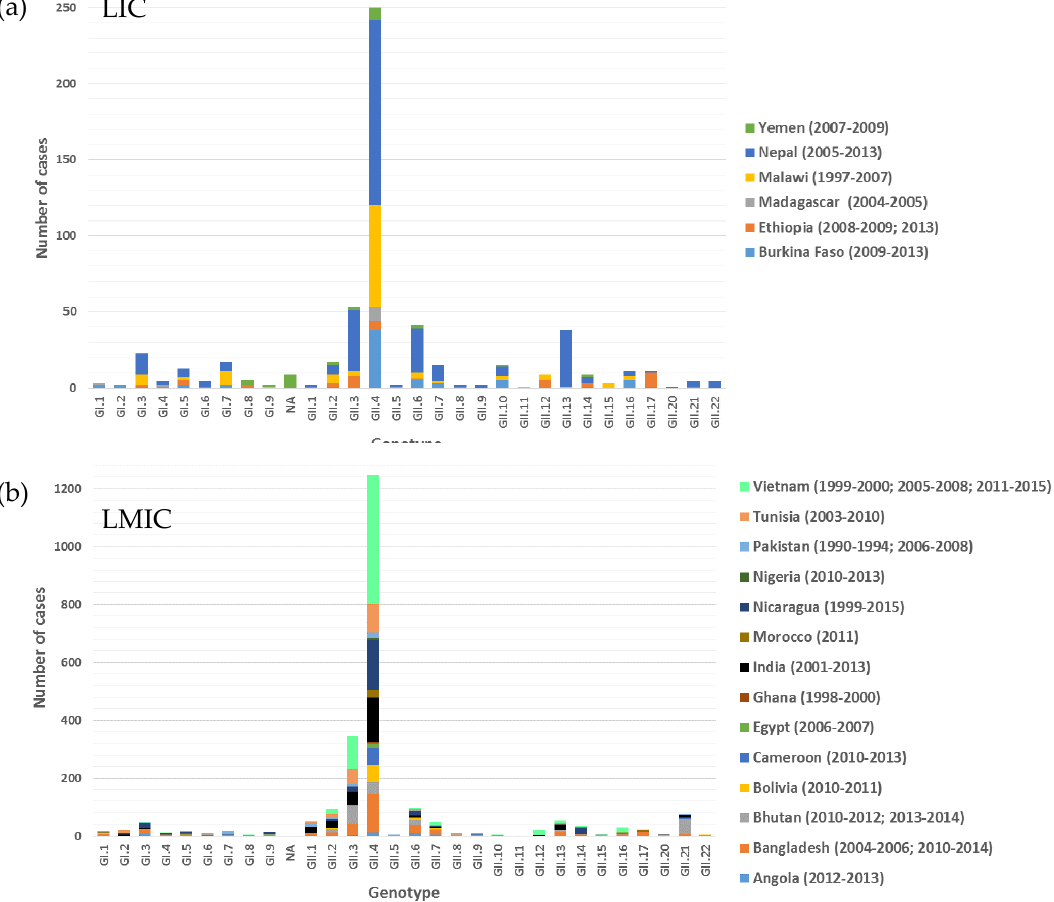
Figure 4. ( a ) The distribution of norovirus capsid genotypes detected in six LIC between 1997 and 2013; ( b ) the distribution of norovirus capsid genotypes circulating in 14 LMIC between 1990 to 1994 and 1998 to 2015. The years in which the studies were conducted are indicated in parenthesis after each country. NA = not assigned a GI genotype.